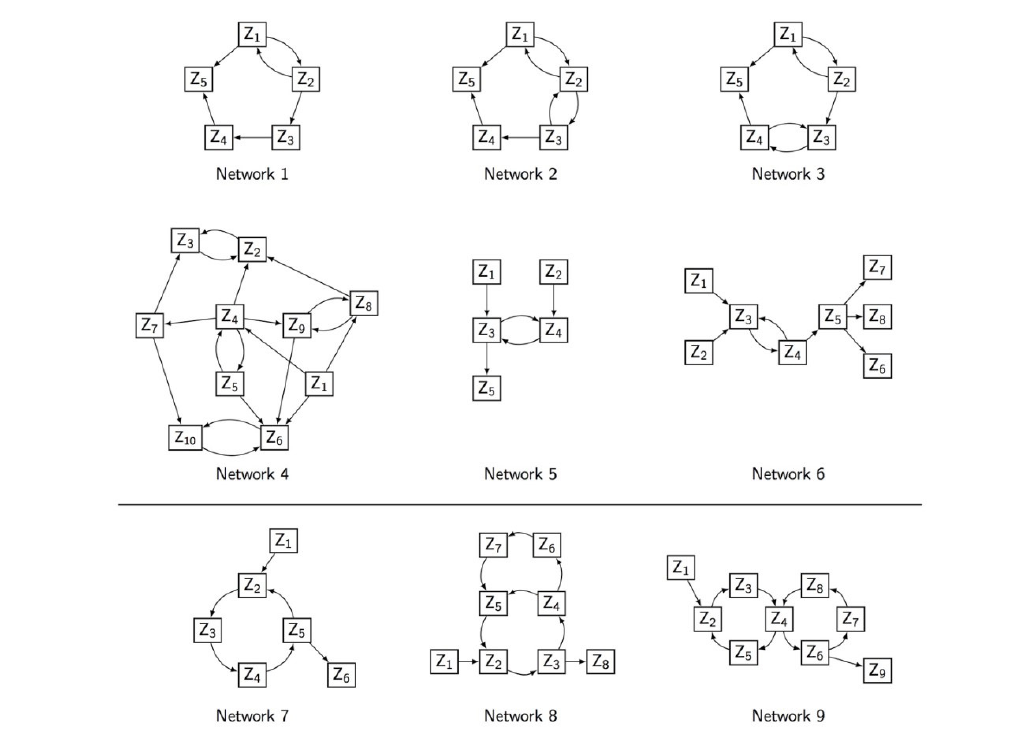
Figure 1: Causal graphical structures used for simulation in Sanchez-Romero, et al., “Estimating Feedforward and Feedback Effective